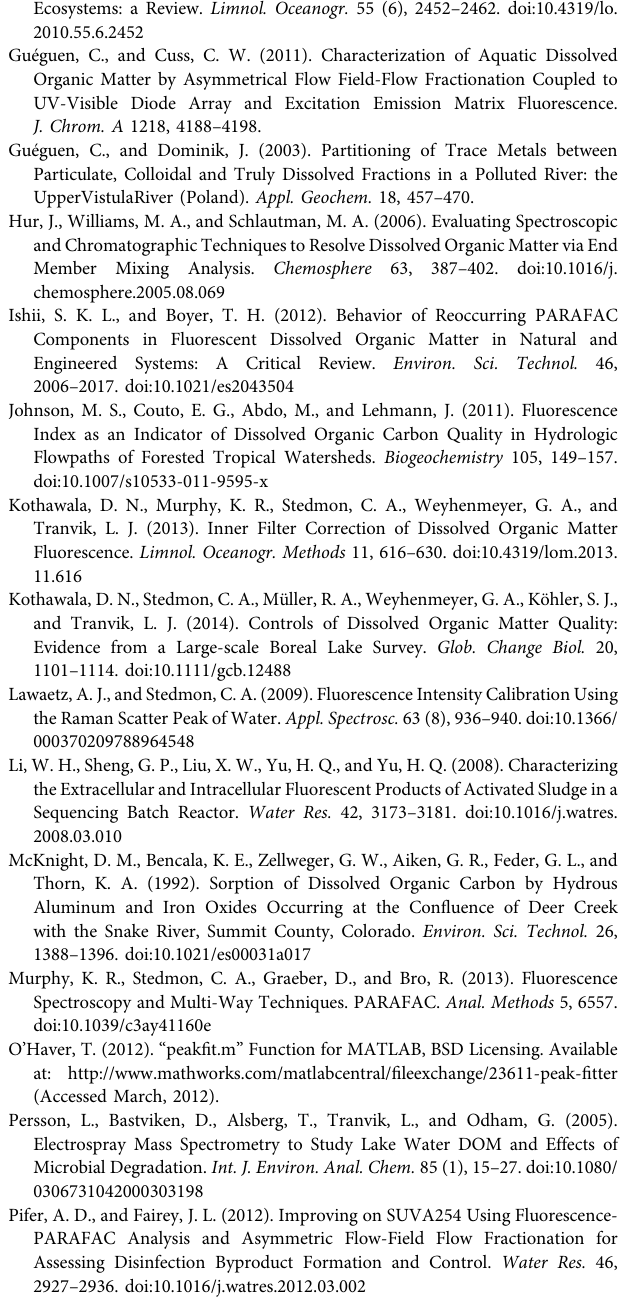
Supplementary Figure S1 | Raw mass spectra for balsam leachate that has been (A) untreated, (B) size-fractionated, and (C) passed through the AF4 separation membrane. Supplementary Figure S2 | Component EEMs from PARAFAC